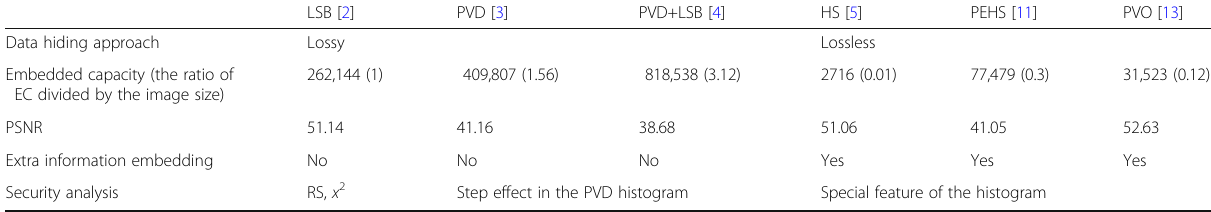
Table 1 Comparison of the various steganographic